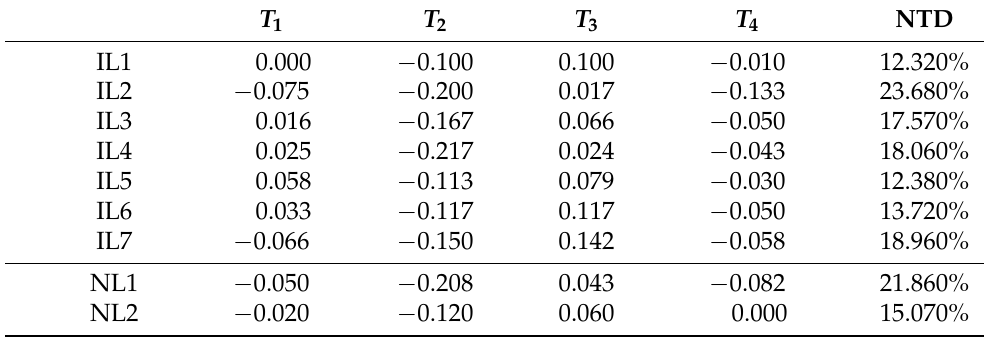
Table 3. Delays and related values for swimmers IL1–IL7 and NL1–NL2: delay durations (in seconds) and NTD.